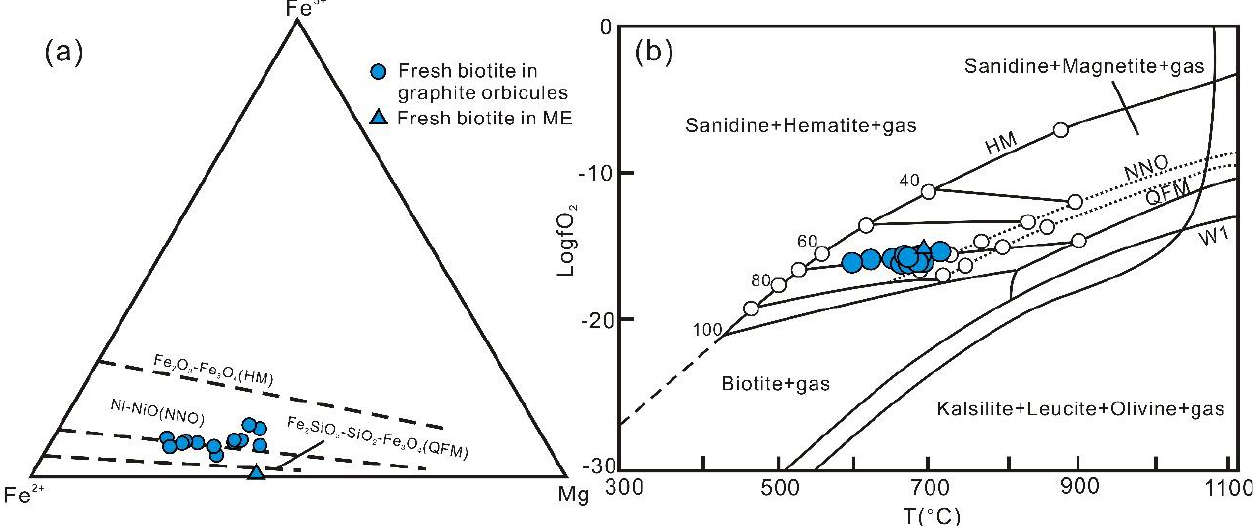
Figure 12. ( a ) Ternary Fe 3+ -Fe 2+ -Mg plot for the Huangyangshan biotite (after [73]). ( b ) Temperature (T) vs. Log(fO 2 ) for the Huangyangshan biotite (after